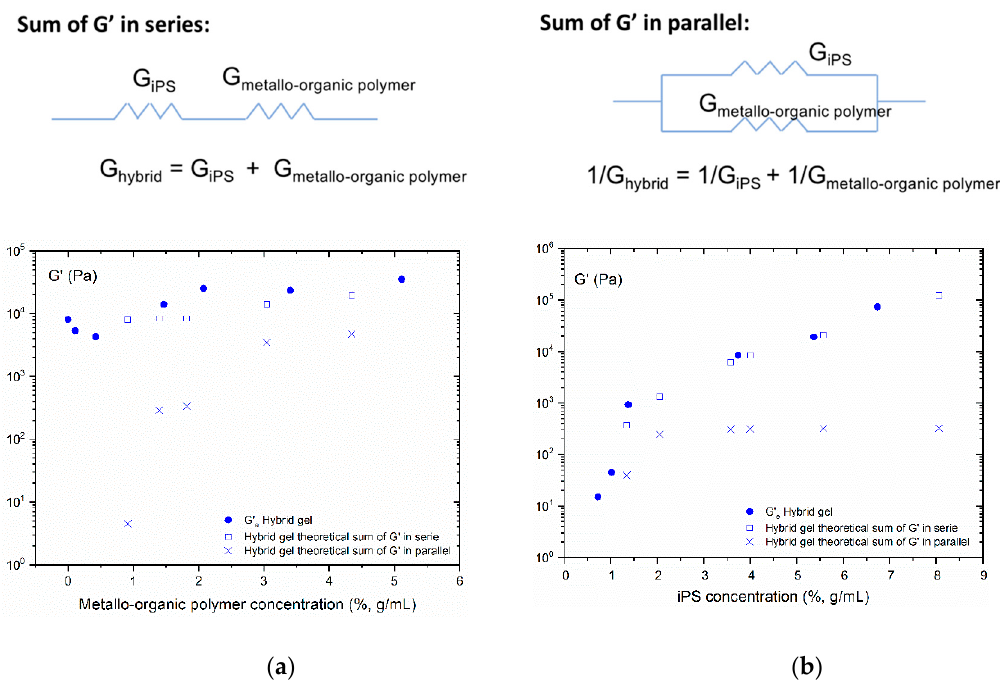
Figure 7. Pictorial scheme of the applied models. Representation of the experimental equilibrium storage modulus as a function of ( a ) metallo-organic polymer concentration ( ● ) and ( b ) iPS concentration ( ● ) and their corresponding theoretical sum of modules in parallel (x) and theoretical sum of the modules in series ( □ ).